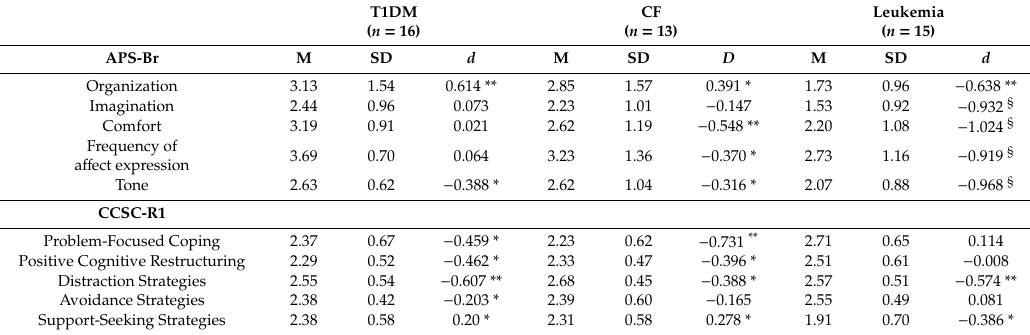
Table 1. Cohen’s d (e ff ect size) for type 1 diabetes mellitus (T1DM), cystic fibrosis (CF), and leukemic children in comparison with normative samples for A ff ect in Play Scale Brief Version (APS-Br) and Children’s Coping Strategies Checklist–Revision1